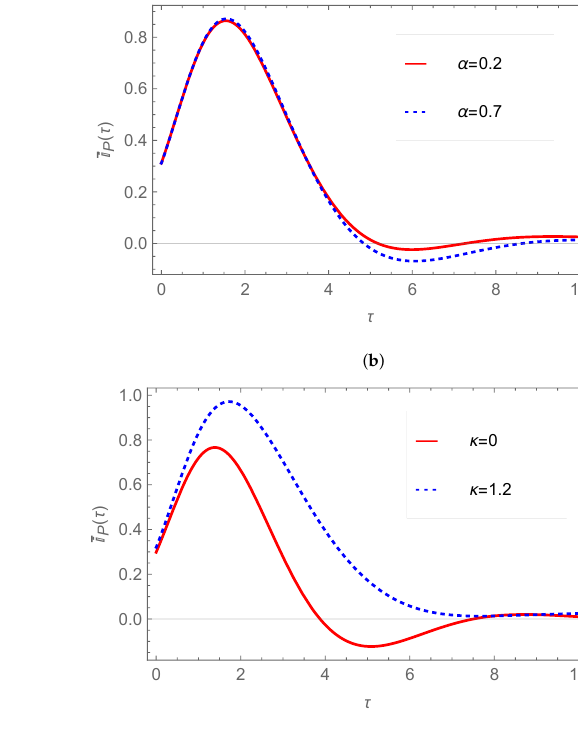
Figure 12. Solution i ( τ ) for different values of A = ω 0 τ L .